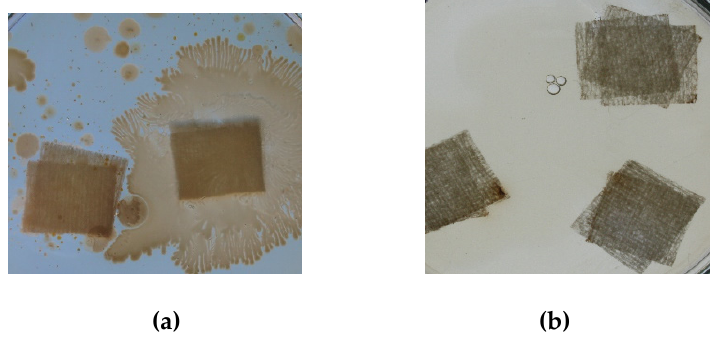
Figure 15. Antimicrobial test. ( a ) Control ( b ) Test.